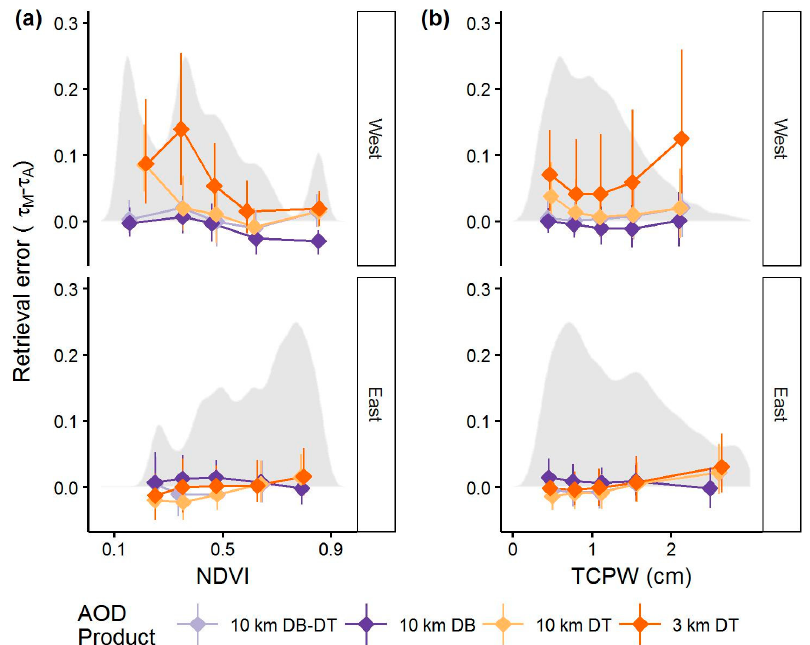
Figure 5. Dependence of AOD retrieval errors and distributions of values in QAC 3 MODIS AOD for NDVI ( a ) and TCPW ( b ). Median AOD retrieval error (dots) and the IQR (vertical line ranges from 25th percentile to 75th) is shown within quintiles of NDVI, and total column precipitable water. The density distribution of values is shown in the background in gray and represents proportional frequency, where 0.25 on the y-axis represents the most frequent value in the category.